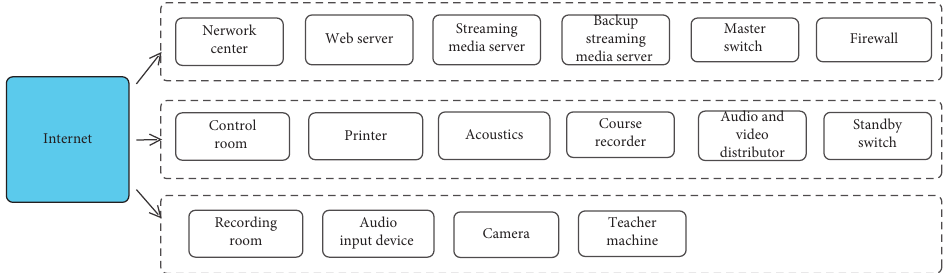
Figure 3: The hardware configuration structure diagram of the training